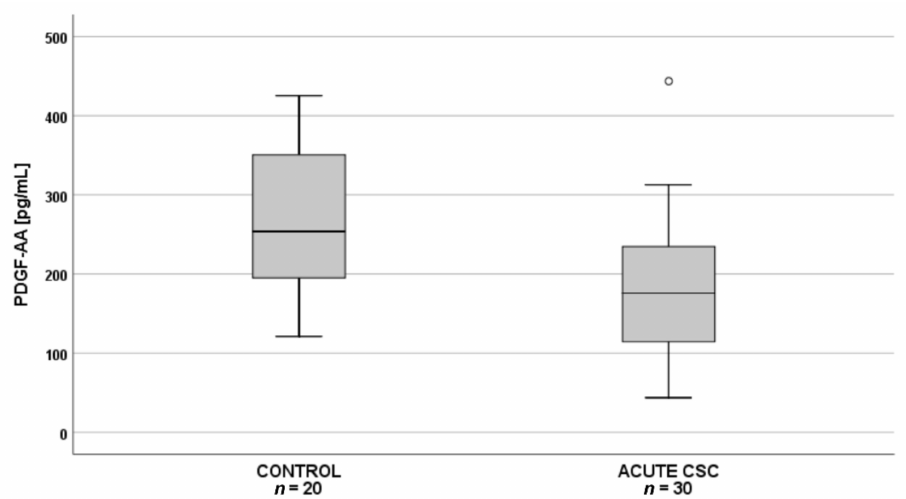
Figure 2. Box-and-whisker plot of plasma pigment epithelium–derived factor (PDGF-AA) levels in patients with acute central serous chorioretinopathy and controls ( p = 0.002; t(48) = 3.252). The line inside the box represents the median; the lower and upper sides of the box represent the lower and upper quartiles, respectively. Whiskers represent cases distant up to 1.5 of interquartile range (IQR) from the respective quartile; circles, cases distant from 1.5 to 3 IQRs. p values were estimated using the analysis of variance post-hoc Bonferroni test.